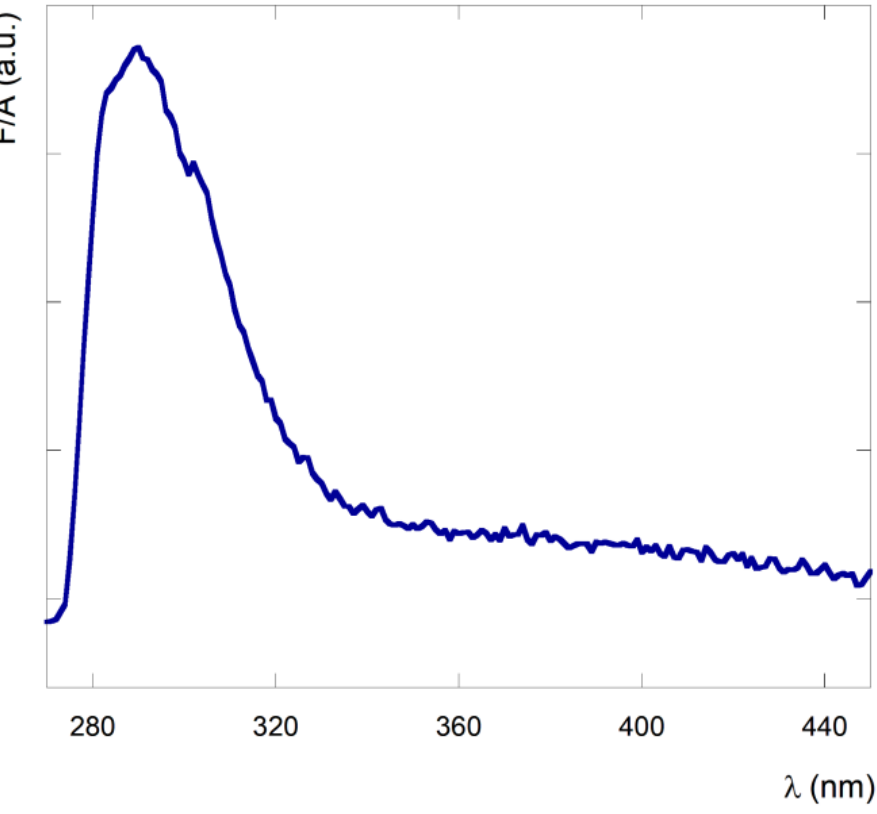
Figure 4. Fluorescence spectrum of peptide 1 in CH 2 Cl 2 solution at a concentration of 2.8 × 10 − 3 M. λ ex = 260 nm.